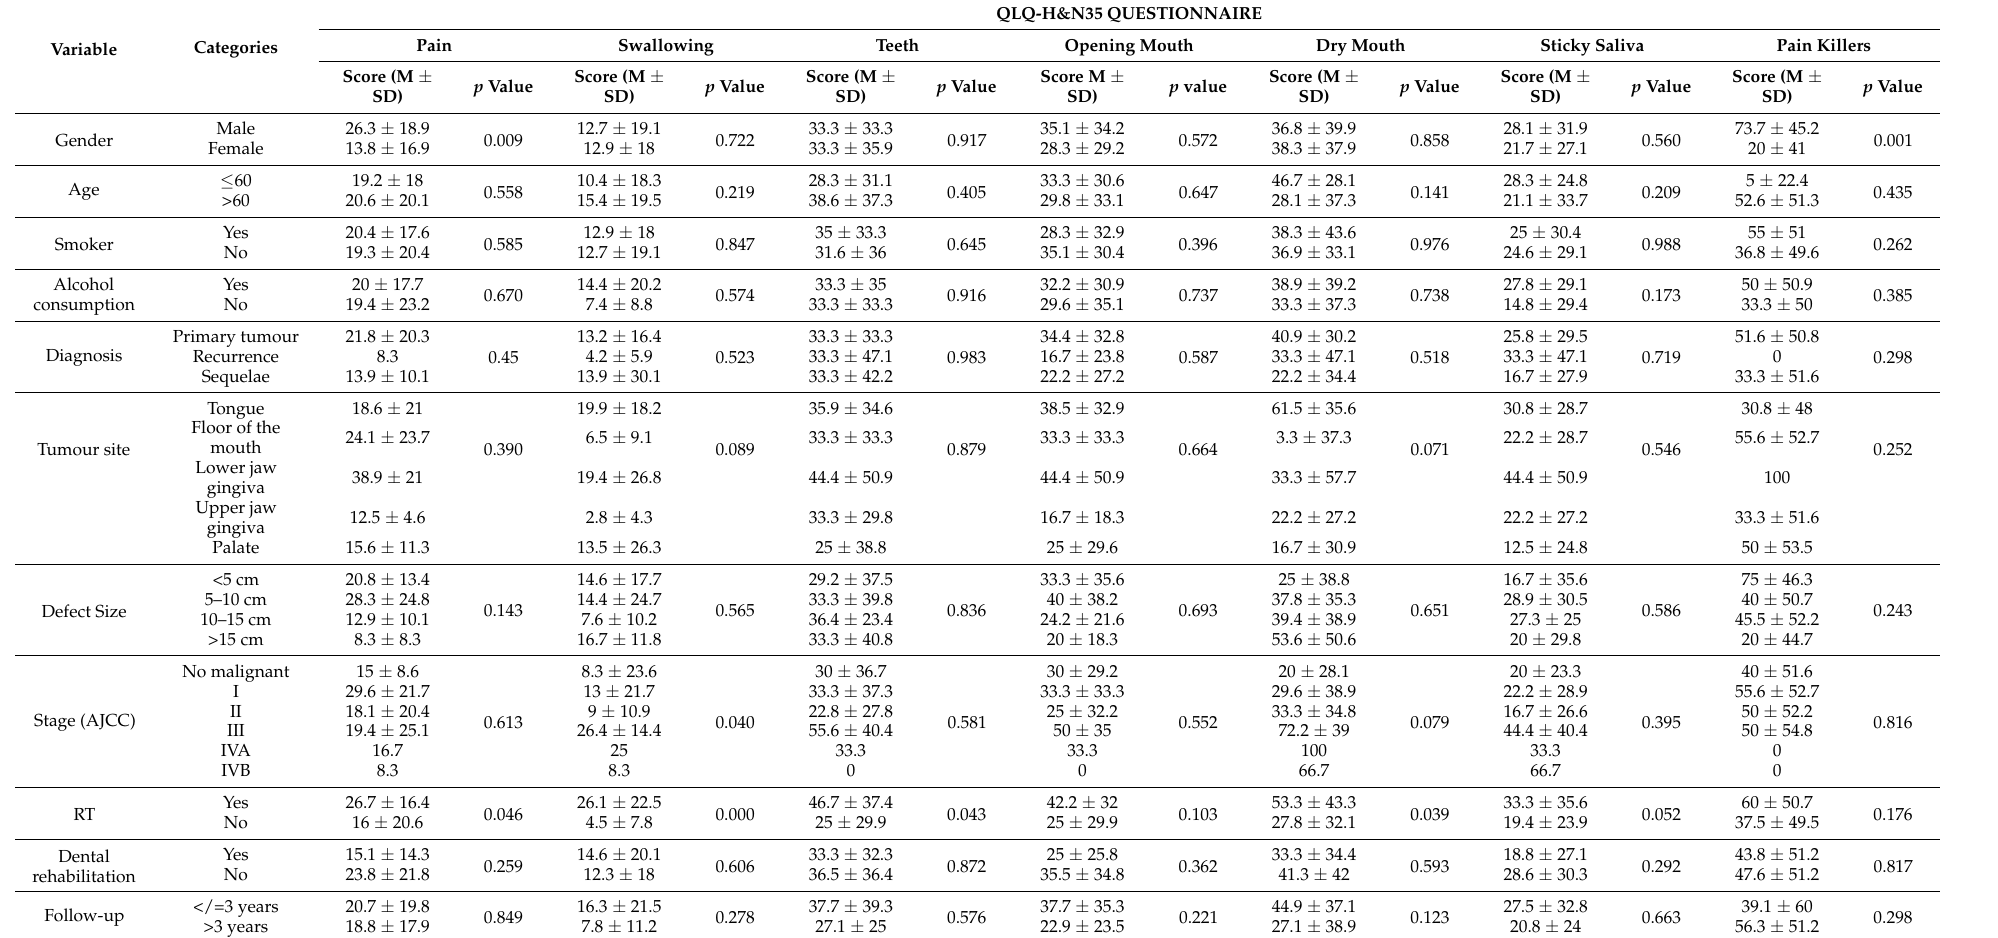
Table 5. Comparison of groups of QLQ-H&N35